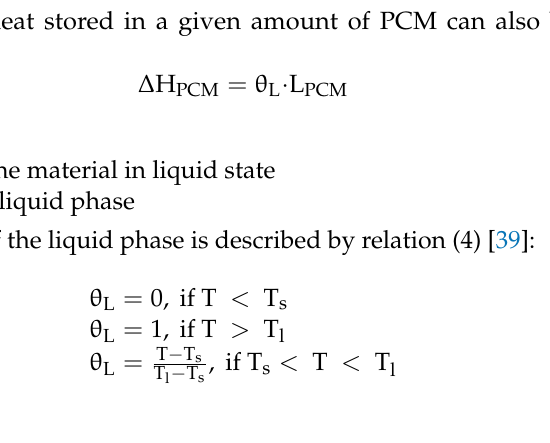
Figure 8. Domains of the TES model: ( a ) first domain, ( b ) second domain, ( c ) third domain.